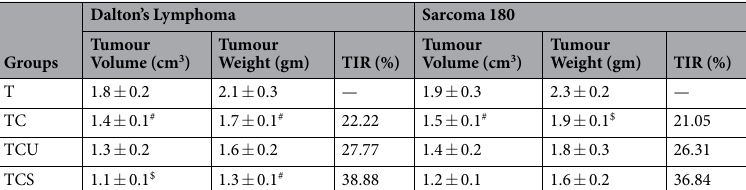
with DNA and produce lesions 30 and (iii) CBDCA can intercalate within DNA that resulted in the formation of the free radicals generated by platinum can damage DNA in spite of their short lifespan. We examined this hypothesis by measuring cellular oxidative and nitrosative stress. As expected, the oxidative burst was observed in CBDCA-treated murine bone marrow cells (Fig. 3A,B). The increment in the levels of cellular ROS and NO level in CBDCA-treated bone marrow cells was also accompanied by an increase in the level of GSSG and decrease in the level of cellular GSH (Fig. 3C,D). Administration of MUS lowered the free radicals generation, lowered the level of GSSG, elevated the cellular level of GSH and thereby recovered murine bone marrow cells from oxidative and nitrosative injury. The antioxidative potential of MUS which was observed during dose selection (Suppl Table 3), can easily explain these findings. So the cytoprotection conferred by MUS may be attributed to the selenium moiety in MUS. MUS alone were found to be less cytotoxic towards transformed cells than 4 MU in vitro . But MUS in combi- nation with CBDCA resulted in better synergistic cytotoxicity in vitro . This may be attributed to the fact that MUS regulates other antiproliferative pathways due to the presence of selenium moieties. In vivo studies revealed that administration of MUS in combination with CBDCA significantly increased the cytotoxicity of CBDCA against